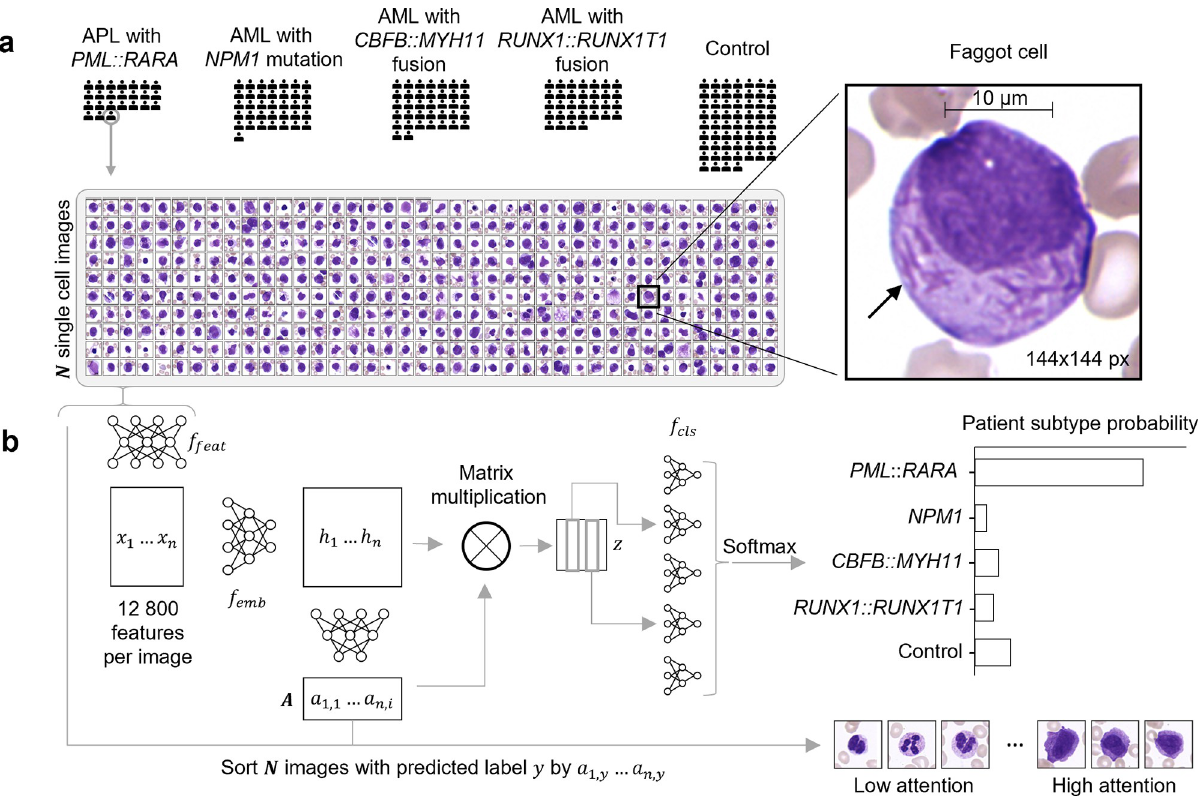
Fig 1. Single-cell based multiple instance learning predicts AML genetic subtypes with high accuracy and identifies clinically relevant cells. (a) Our cohort consists of 81214 single-cell images from 189 individuals comprising four genetic AML subtypes (APL with PML :: RARA fusion (n = 24), AML with NPM1 mutation (n = 36), AML with CBFB :: MYH11 fusion (n = 37), AML with RUNX1 :: RUNX1T1 fusion (n = 32)) and 60 healthy controls. Single white blood cells were selected and digitized from peripheral blood smears (see Methods). The single-cell images of an exemplary PML :: RARA patient (bottom) contain a PML :: RARA specific faggot cell (right) with clearly visible bundles of Auer rods (arrow). (b) Our single-cell based explainable multiple instance learning algorithm (SCEMILA) classifies patients with an arbitrary number of single-cell images and sorts them by attention. From N single-cell images, features are extracted with a pre-trained convolutional neural network f feat . A bag feature vector is generated via matrix multiplication, which allows patient classification. Moreover, single-cell images can be ordered according to attention, i.e. their importance for a class